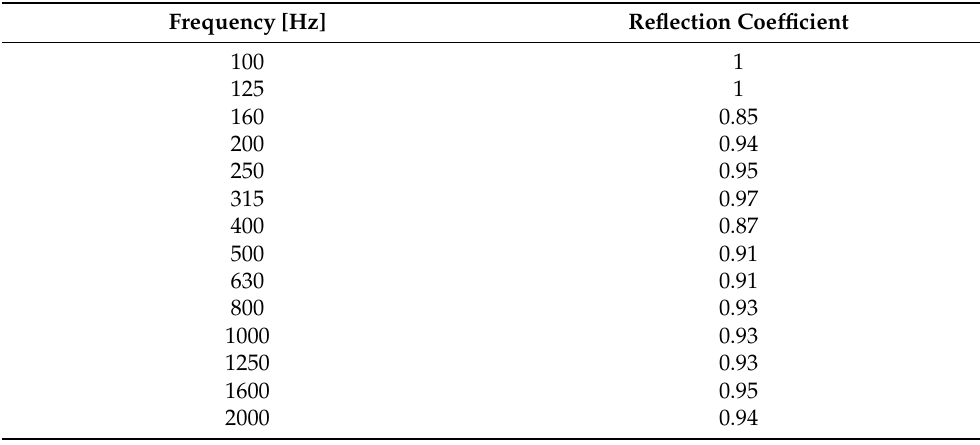
Table 1. Reflection coefficient of the aluminium plate in the passive